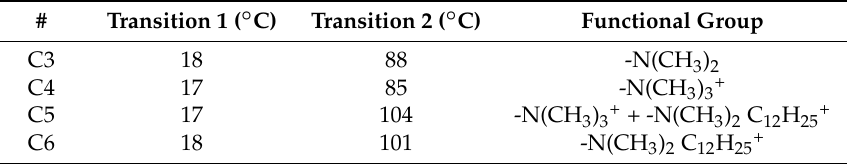
Table 4. Transition temperatures for nonquaternized C3 and its cationic